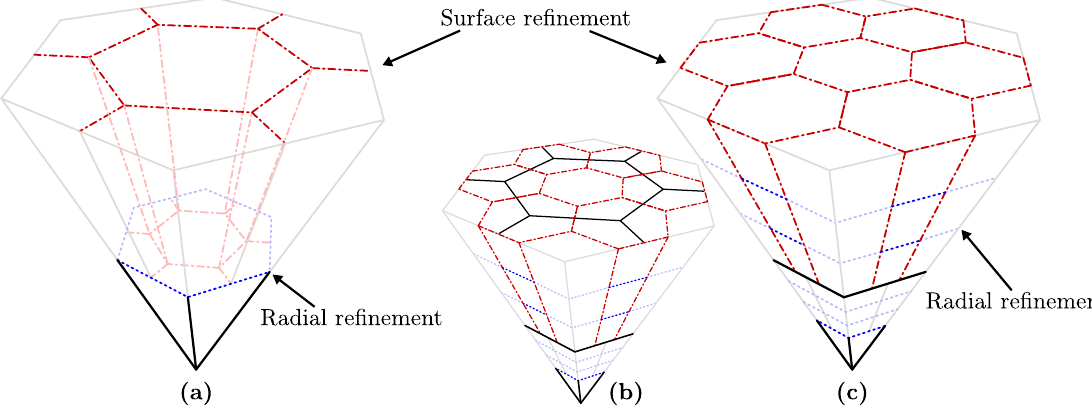
Figure 7. Semiregular prismatoid refinement applied to a hexagonal base cell using a 1:3 surface refinement scheme ( a ) once and ( c ) twice; ( b ) is the same image as ( c ), but with the surface cells of the previous refinement level shown for reference. Note that in the second level of refinement, normal layers have two radial refinements as opposed to